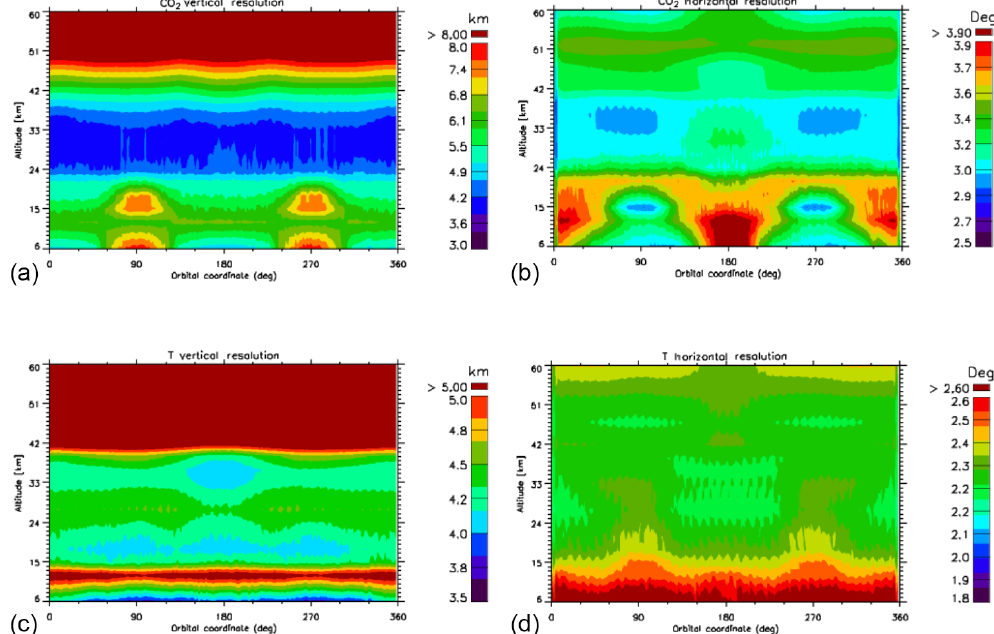
Figure 7. Maps of the vertical ( a and c ) and horizontal ( b and d ) resolutions as a function of altitude and orbital coordinate obtained with the averaging kernel matrix of the sample test retrieval. Panels (a–b) refer to the retrieved CO 2 field and panels (c–d) refer to the retrieved T field.